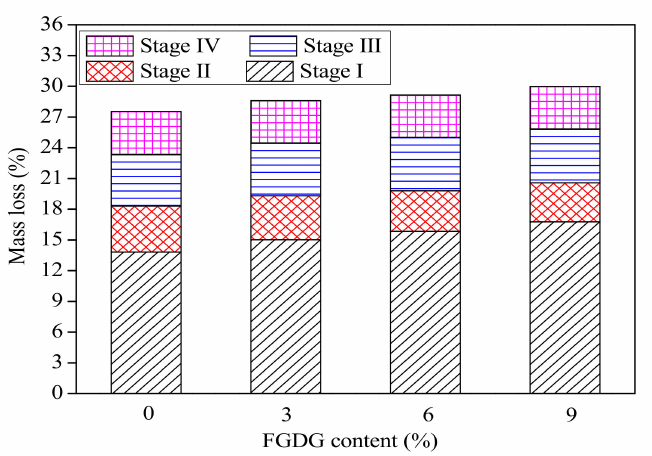
Figure 9. The mass loss at different stages for CSAC-GGBFS mixtures with different FGDG content hydrated for 120